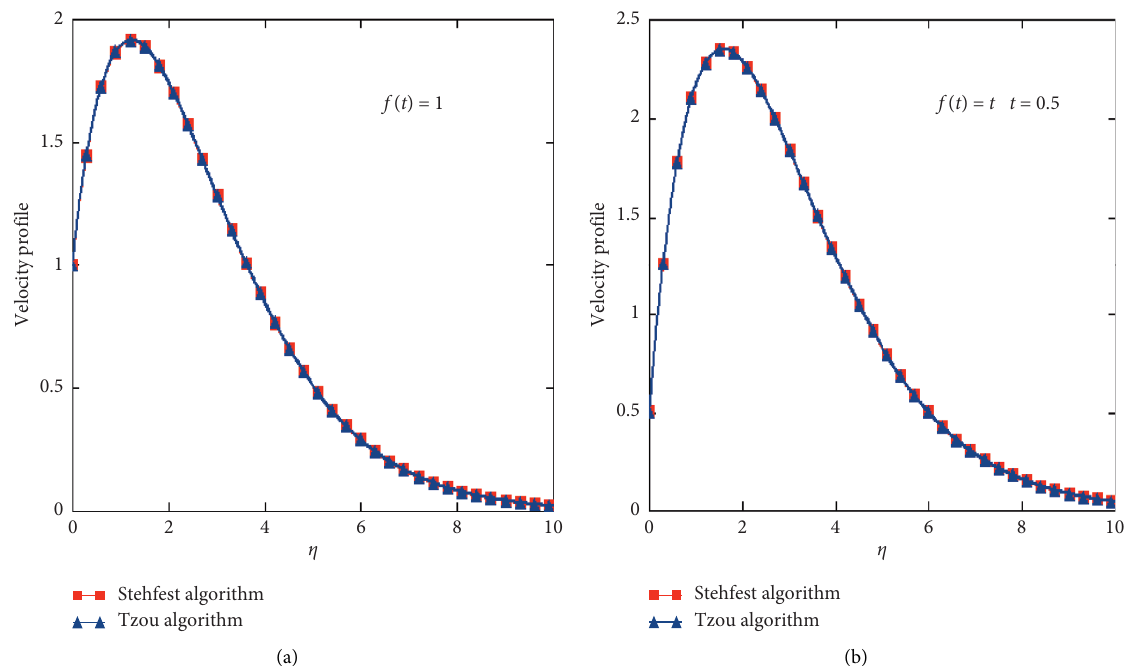
Figure 3: Profile of inverted velocity with Stehfest’s and Tzou’s algorithms for (a) f ( t ) � 1 and (b) f ( t ) � t